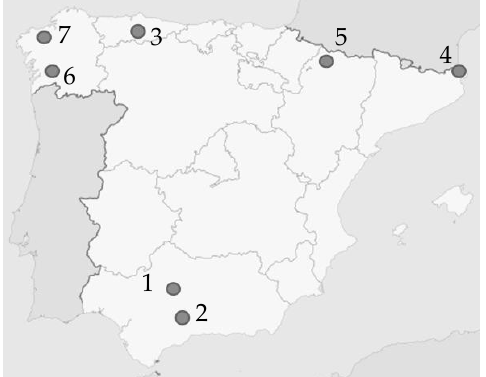
Figure 1. Approximate location of the bridges. 1.”Bembézar” PK 41/548 “Cordoba-Sevilla” line; 2. “Corbones” PK 528/318 “Madrid-Sevilla” line; 3. “Caudal” PK 018/525 “Trubia-Collanzo” line; 4.”Colera” PK 270/500 “Tarragona-Barcelona” line; 5. “La Peña” PK53/161 “Huesca-Jaca” line; 6. “Carballo” PK 0/909 “Redondela-Santiago de Compostela” line; 7. “Tea” PK 129/493 “Chapela-Le- mos”.